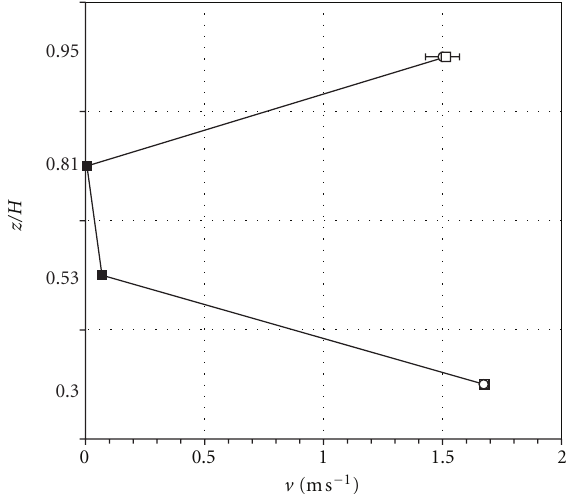
Figure 5: Comparative profiles of the air velocity, v ( y / W = 0.38, z / H ) (ms − 1 ) (see CSML in Figure 1(b)). (Legend: numerical: (cid:2) ; experimental: (cid:6)